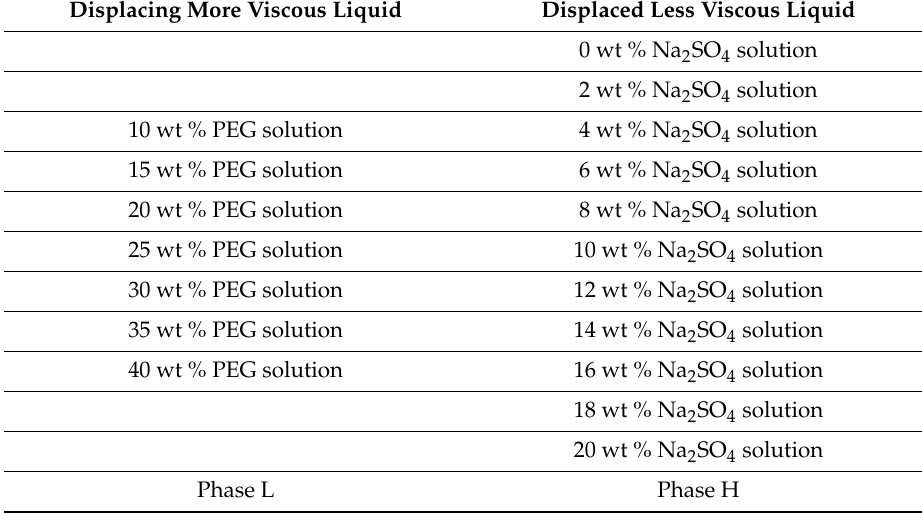
Table 1. The solution system used.